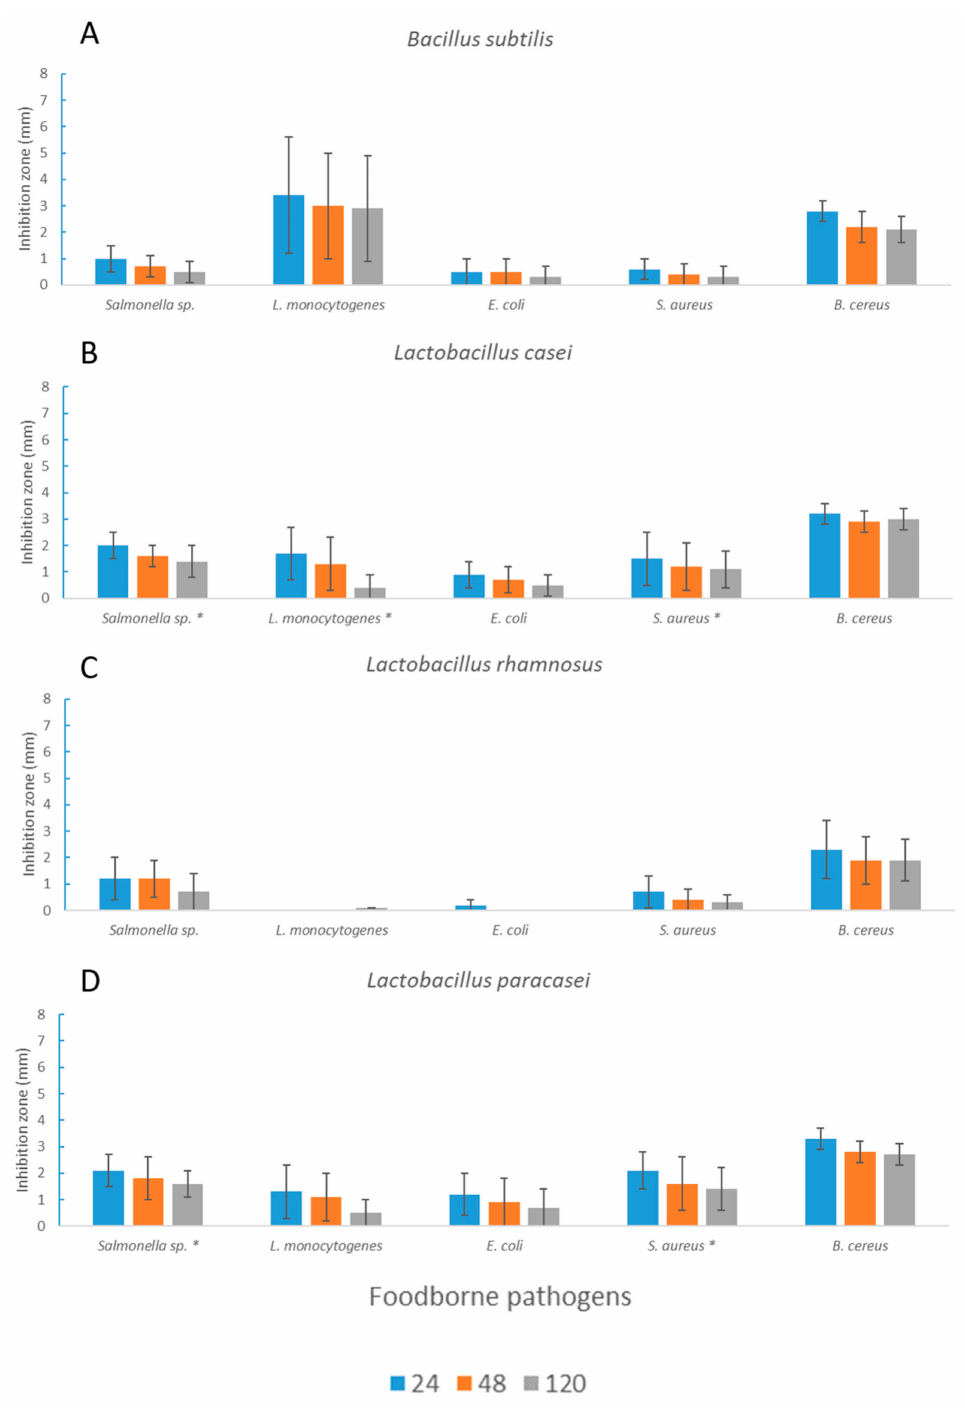
Figure 4. Inhibition radius (mm) of HE I extracts after 72 h of fermentation. Measurements were taken after 24, 48, and 120 h. Average values ± standard deviations are reported. Here, * expresses the significance ( p < 0.05) of H. elongata fermented with B. subtilis , A, and the same seaweed fermented with the L. casei group ( L. casei , B, L. rhamnosus , C, and L. paracasei , D) of